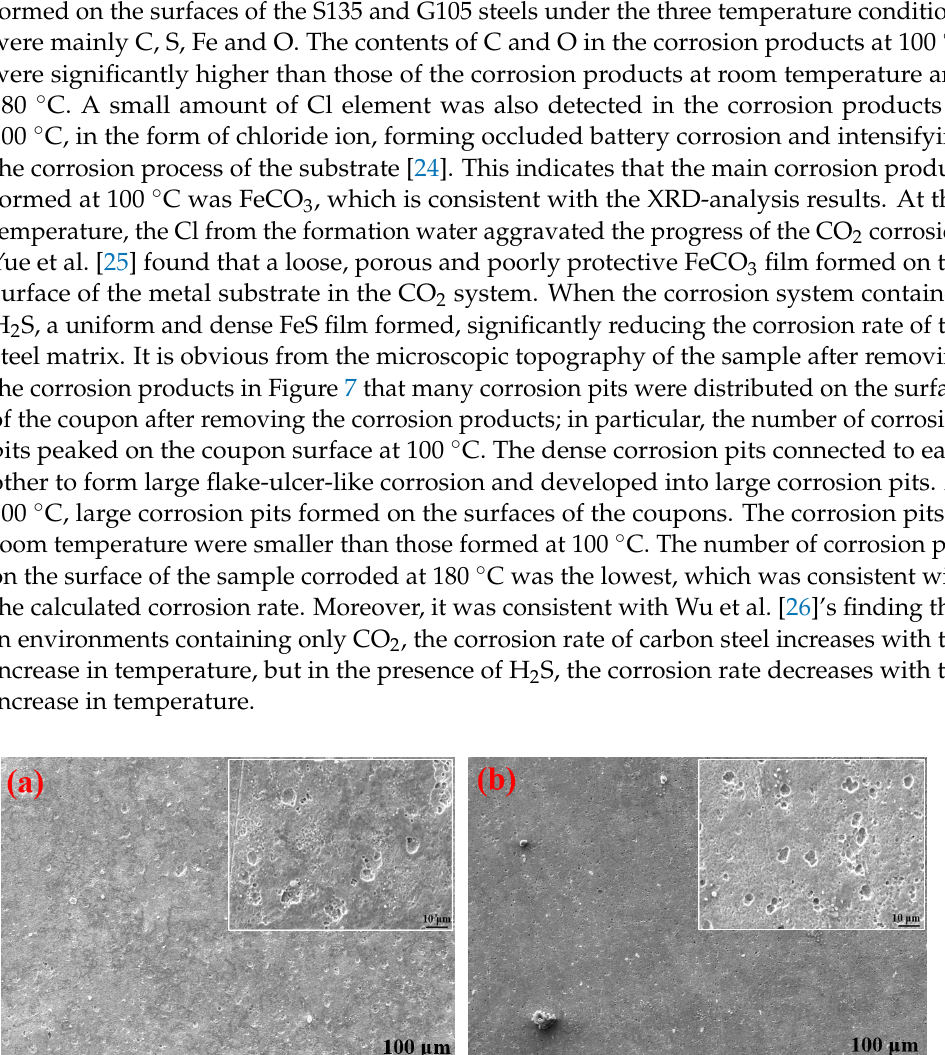
Table 4. Elemental composition of corrosion products according to energy spectra of S135 and G105 at room temperature (wt.%).